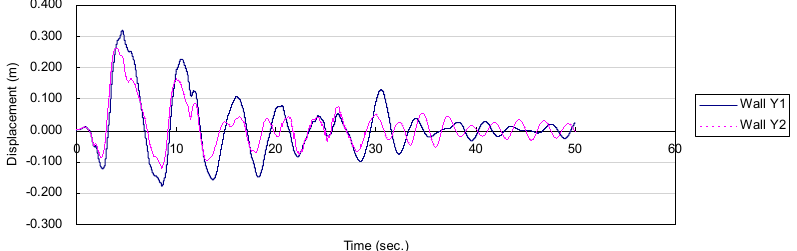
( a ) Displacement history of the y -directional walls.